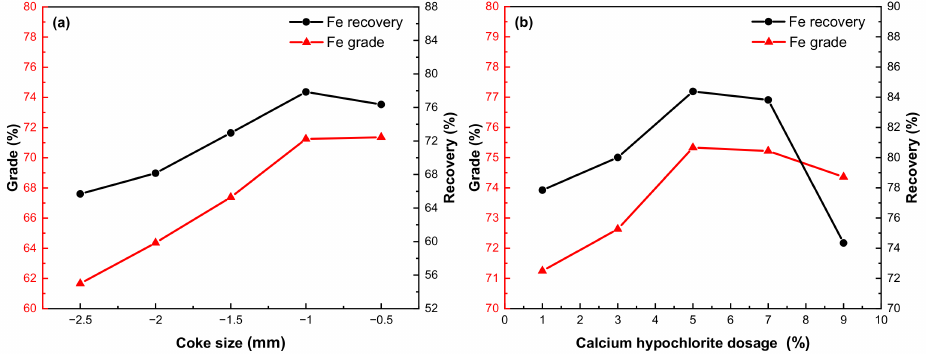
Figure 5. Effects of coke size ( a ) and calcium hypochlorite dosage ( b ) on iron